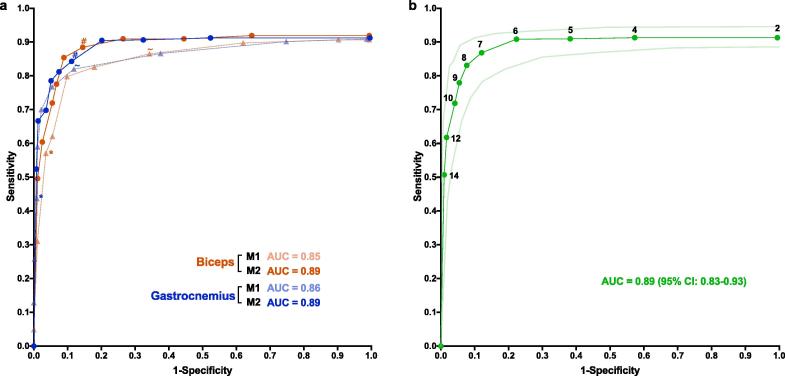
Receiver operating characteristic (ROC) curves for FP identification (phase three). (a) Comparison of two analytical models. For each muscle (biceps in red and gastrocnemius in blue), 40 one-minute representative recordings were analysed. Model one (M1, triangle symbols) took the form Y = A1 and model two (M2, circular symbols) took the form Y = A2X, where Y was the optimal ATinc (μV), X was the mean noise band (μV) and A1/2 was a positive value. From left-to-right, threshold values for A1 were 100, 60, 40, 35, 30, 25, 20, 15, 10 and 5, and values for A2 were 14, 12, 10, 9, 8, 7, 6, 5, 4 and 2. Median sensitivity and specificity are displayed (non-parametric distributions). Area-under-the curve (AUC, 2 s.f.) represents the accuracy of each model for each muscle. * indicates the performance of M1 when A1 = 40; ∼ indicates performance of M1 when A1 = 20; # indicates the performance of M2 when A2 = 7. (b) Pooled results for model two. The results from biceps and gastrocnemius were pooled to produce a total of 80 one-minute recordings. Threshold values for A2 are displayed. Curves for median sensitivity and specificity are plotted alongside lower and upper limits for 95% confidence interval (CI). AUC represents the accuracy of this model. (For interpretation of the references to colour in this figure legend, the reader is referred to the web version of this article.).